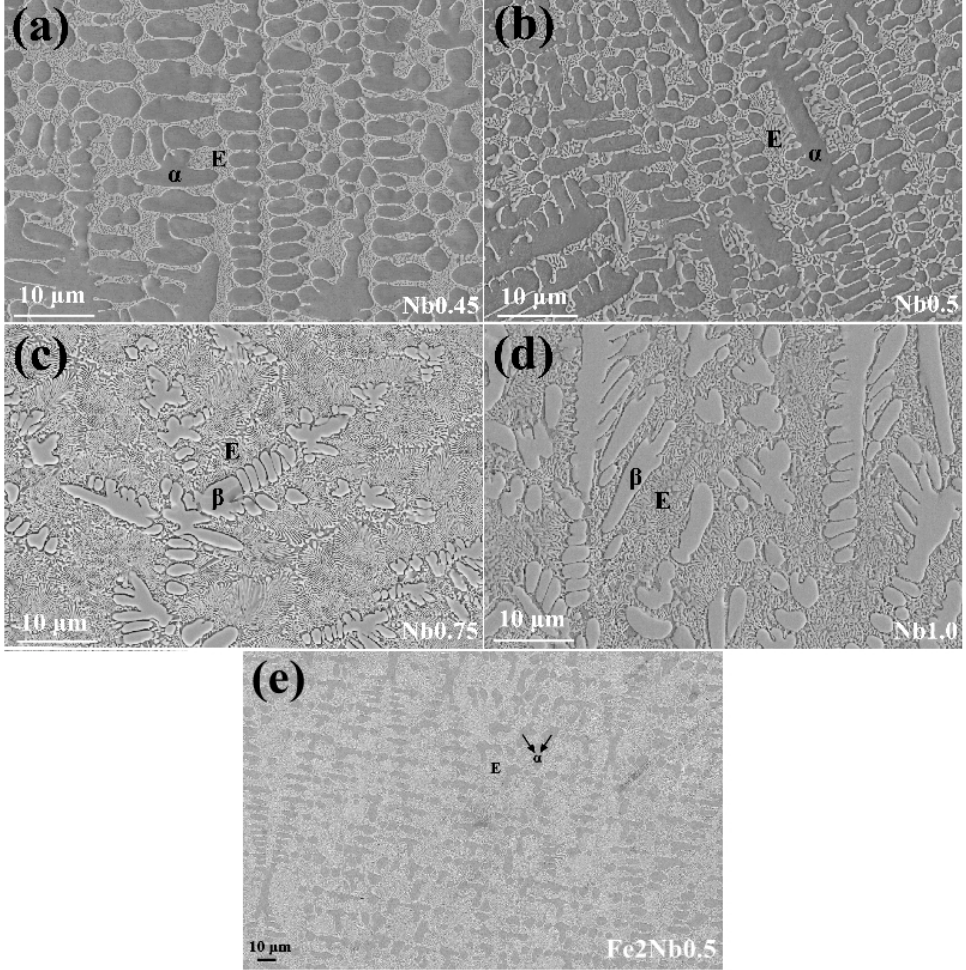
Figure 3. SEM images of the central area in the cladding zone of CoCrFeNiNb x HEA coatings ( a ) Nb0.45, ( b ) Nb0.5, ( c ) Nb0.75, ( d ) Nb1.0, ( e ) Fe2Nb0.5.